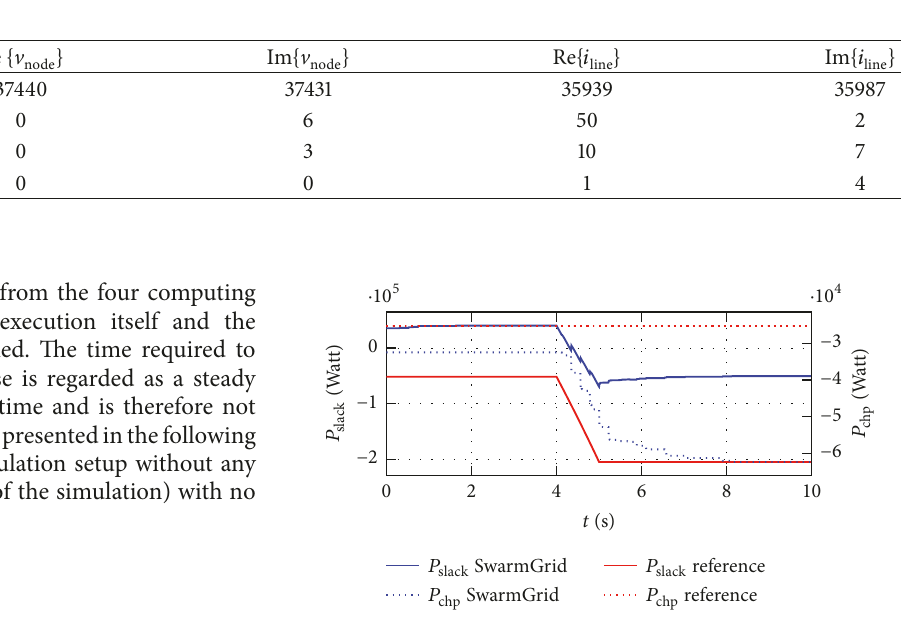
Figure 11: Active power behavior of slack bus and